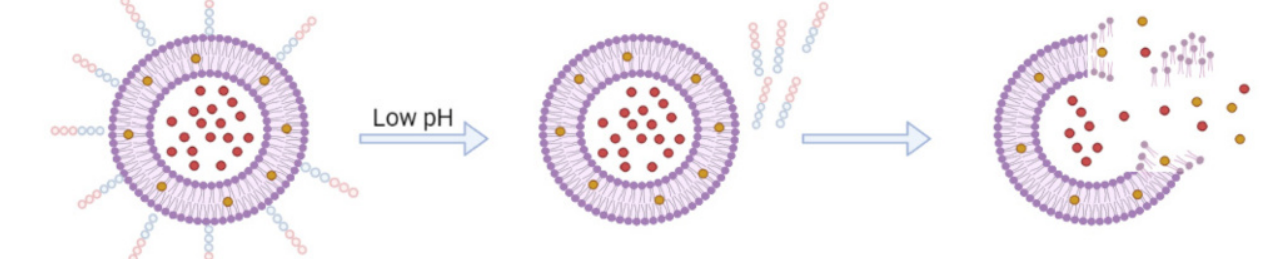
Figure 13. Schematic representation of pH-sensitive liposomes. Created with BioRender.com (ac- cessed on 10 January